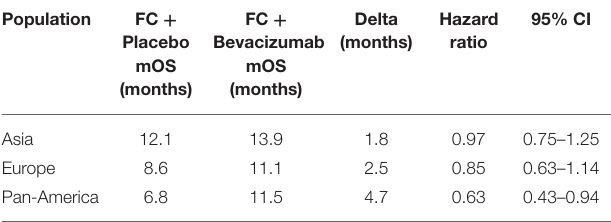
TABLE 3 | Summary of mOS subgroup analysis in